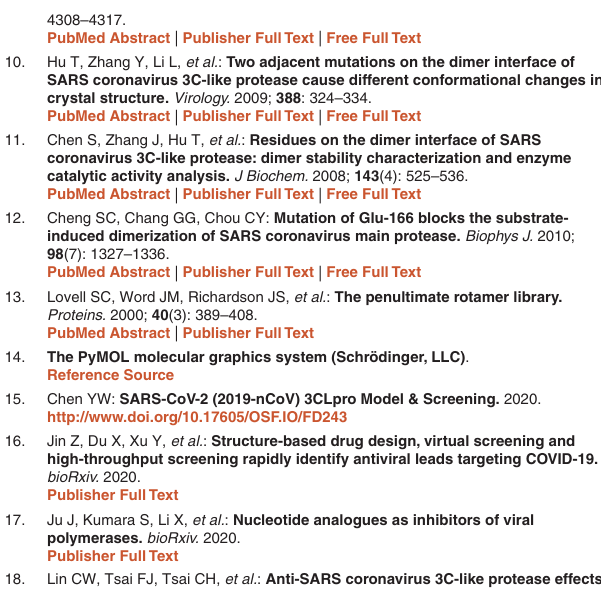
Compare Crystal.docx (A comparison, with Figure S2, of the active sites of model chains A, B and the crystal